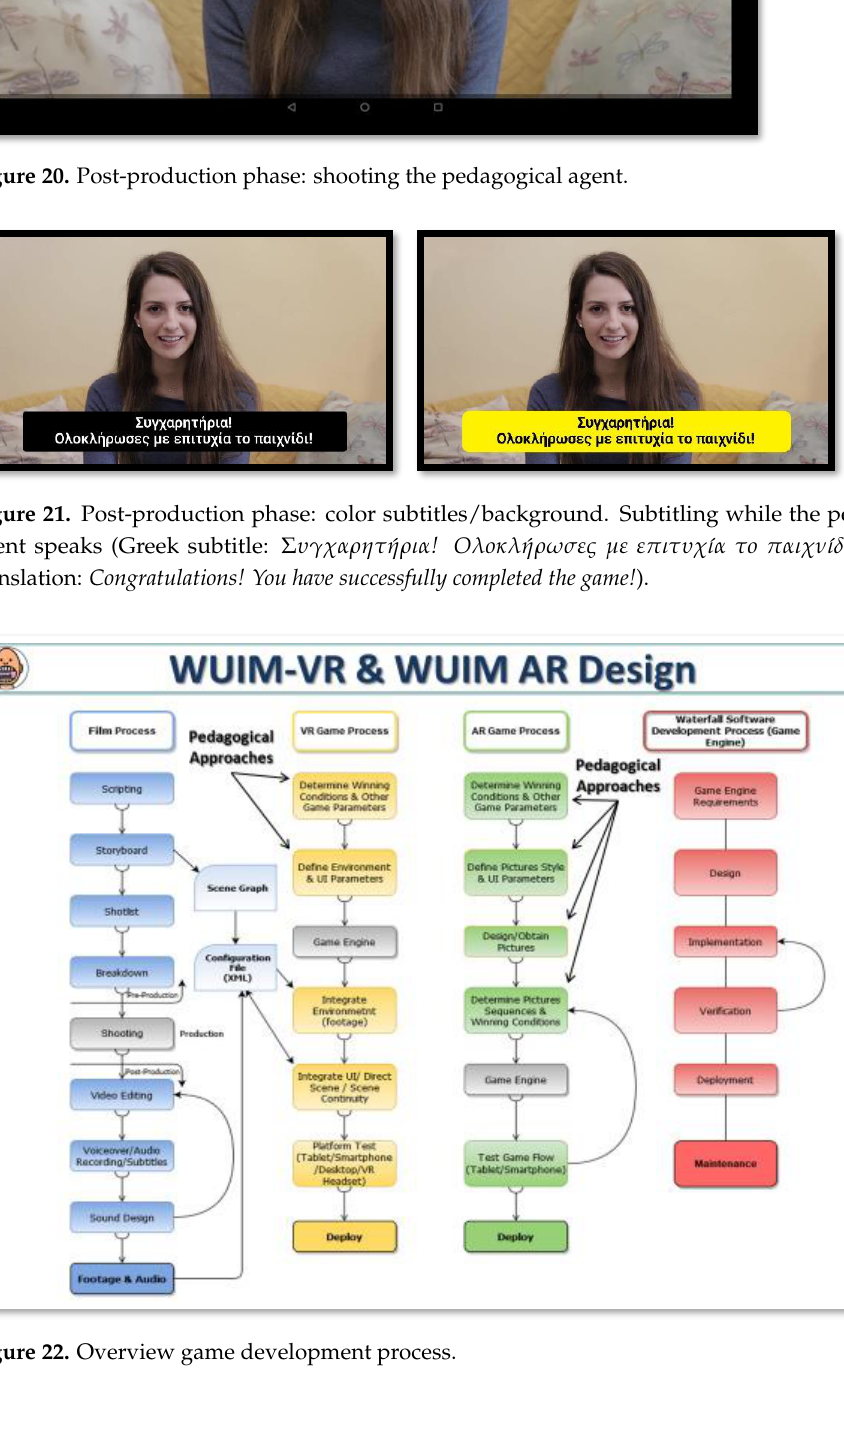
Figure 22. Overview game development process.